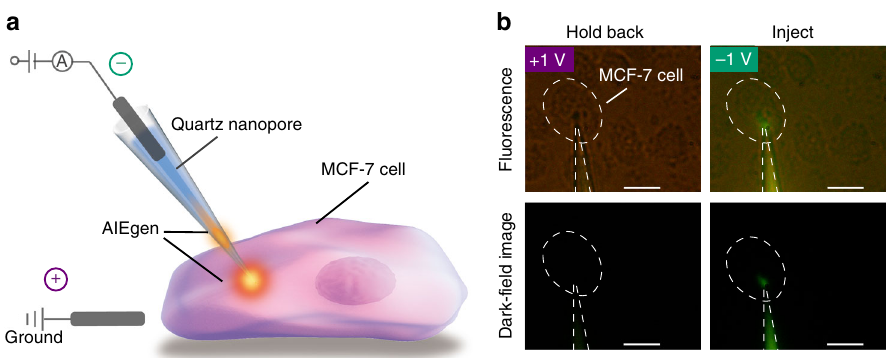
Fig. 3 Cell injection of DMTPS-DCV using electrochemically nanopore manipulation. a The illustration for the cell injection. The DMTPS-DCV is sucked into the nanopore at 1 V, then the nanopore is translated toward the cell and penetrates through the cell membrane. The DMTPS-DCV is injected inside the cell at − 1 V. b The fl uorescence micrographs (upper) and dark- fi eld images (bottom) of immobilized MCF-7 cell. Left: After quartz nanopore punches into the cell, the DMTPS-DCV is hold back away from the nanopore tip at 1 V, leading to the less emission at the nanopore tip; Right: DMTPS-DCV is electrochemically driven into the single cell at − 1 V, which enlightens the intra cell. The concentration of DMTPS-DCV in this injection is 10 mM. Scale bars, 20